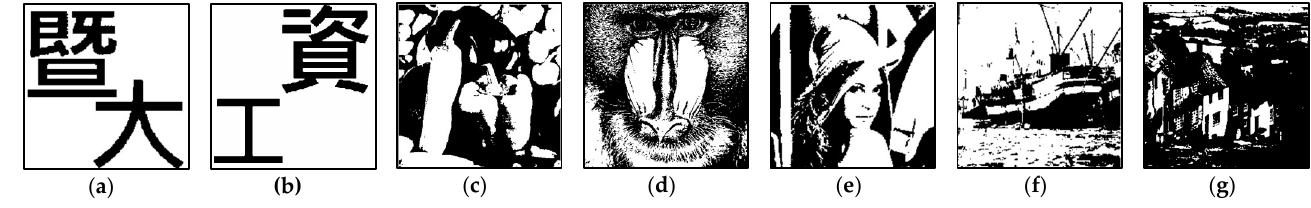
Figure 5. ( a , b ) Secret images S 0 , S 1 , ( c )–( g ) Camouflage images D 0 , …, D 4 .